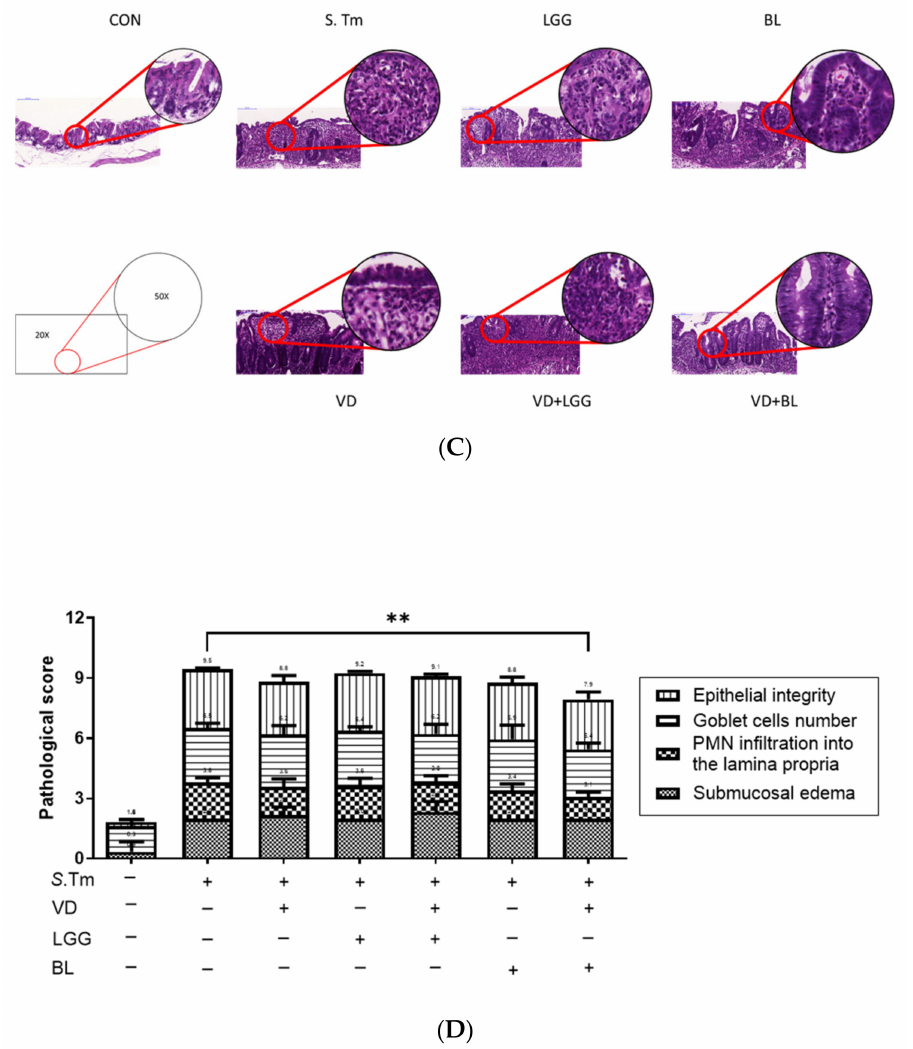
Figure 1. Combination of probiotics and active 1, 25 D3 attenuates the severity of Salmonella colitis in mice. We orally infected 6 − 8 week-old female C57BL/6 mice with 10 8 CFU of SL1344 ( S .Tm). Before and after infection, mice were gavaged with vehicle control (5% dimethyl sulfoxide), 1,25 D3 (VD), Lactobacillus rhamnosus GG (LGG) or Bifidobacterium longum (BL), daily as shown above. Loss of body weight ( A ) and scores of diarrhea situation ( B ) in mice were recoded daily. Cecum was resected and fixed in formaldehyde, and sections were stained with hematoxylin and eosin stain. ( C ) Representative histological images ( × 20 and × 50 magnification) of cecum from the different experimental groups. ( D ) The pathological scores for colitis at the cecum of mice. The data shown are means ± SEM ( n = 6 mice/group). ** p <